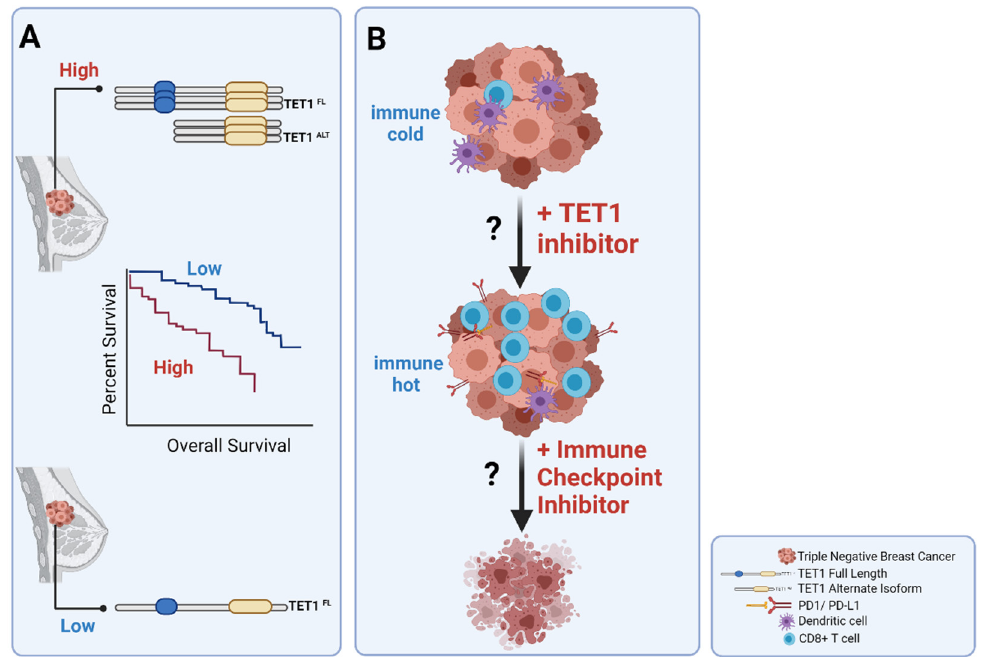
Figure 2. Proposed model for therapeutic potential of TET1 in TNBC. ( A ) TNBC tumors can be subdivided into TET1-low and TET1-high (full length and/or alternate isoform) groups. Patients with high TET1 tumors have worse overall survival compared to patients with low TET1 tumors as indicated in the Kaplan–Meier curves. ( B ) Tumors with high TET1 are characterized by low immune response genes and are immune-cold. The model suggests that inhibition of TET1 will result in activation of immune pathway genes that could potentially respond to immune checkpoint inhibitors and improve overall